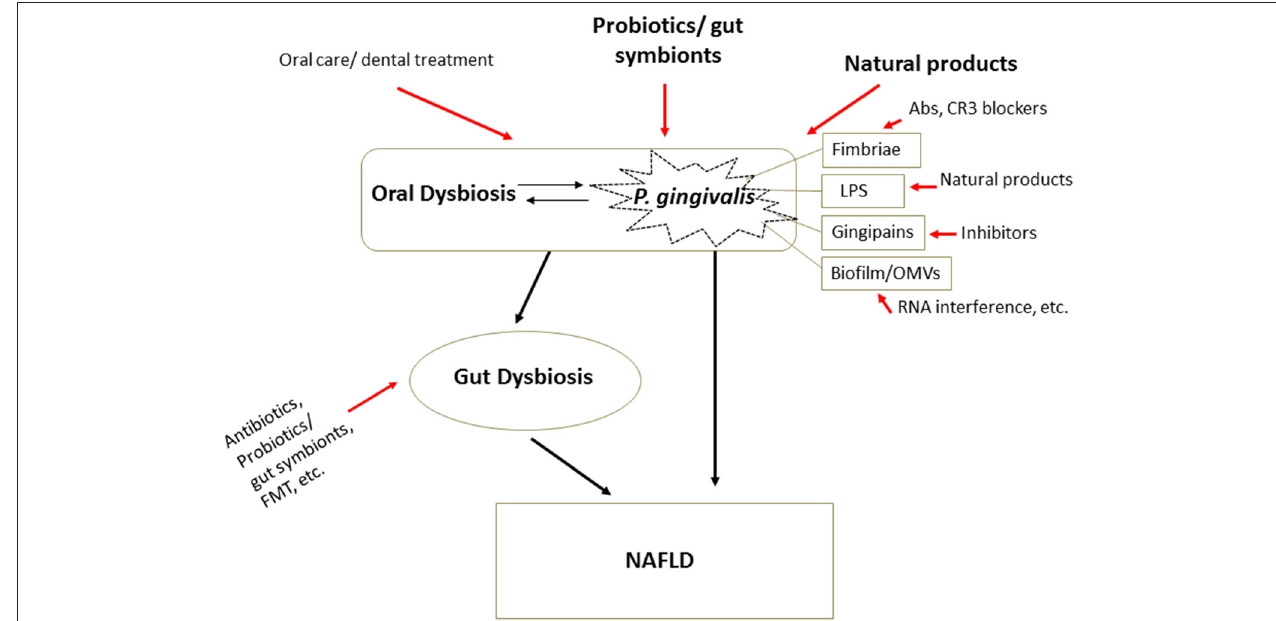
FIGURE 3 | Therapeutic strategies in microbial dysbiosis-related NAFLD. Understanding the mechanism underlying microbial dysbiosis and its impacts on the pathogenesis of NAFLD through the gut-liver, oral-liver, and oral-gut-liver axes may contribute to the development of new options for treatment of the disease. Some very safe options, such as some probiotics, gut symbionts, and natural products, aimed at attenuating oral bacteria and correcting dysbiosis of the oral and gut microbiota, have received substantial attention. Additionally, treatments targeting the structures and virulence factors of P. gingivalis offer new treatment options specifically targeting bacteria. Abs, antibodies; FMT, fecal microbiota transplantation.